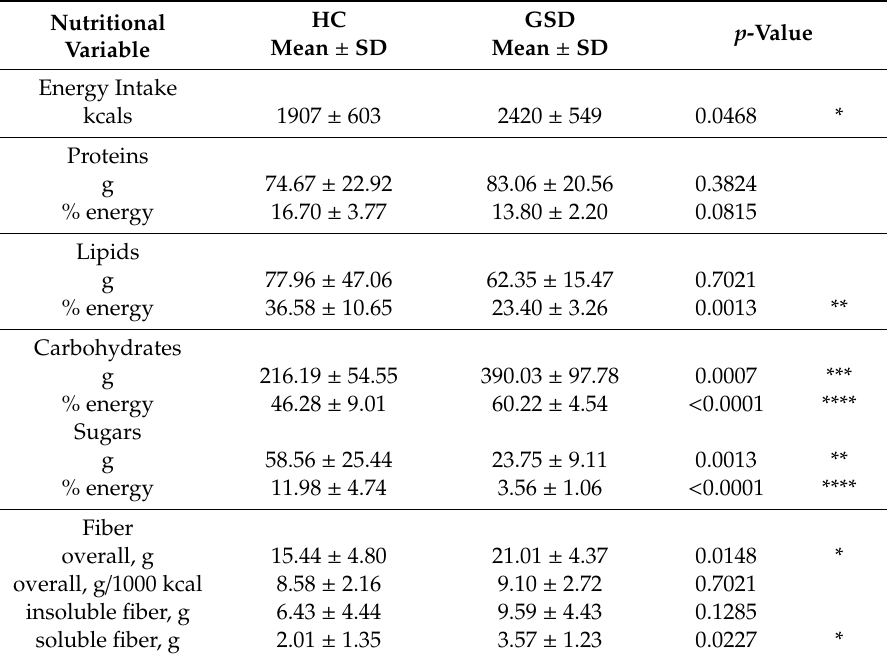
Table 1. Nutritional values of the two enrolled